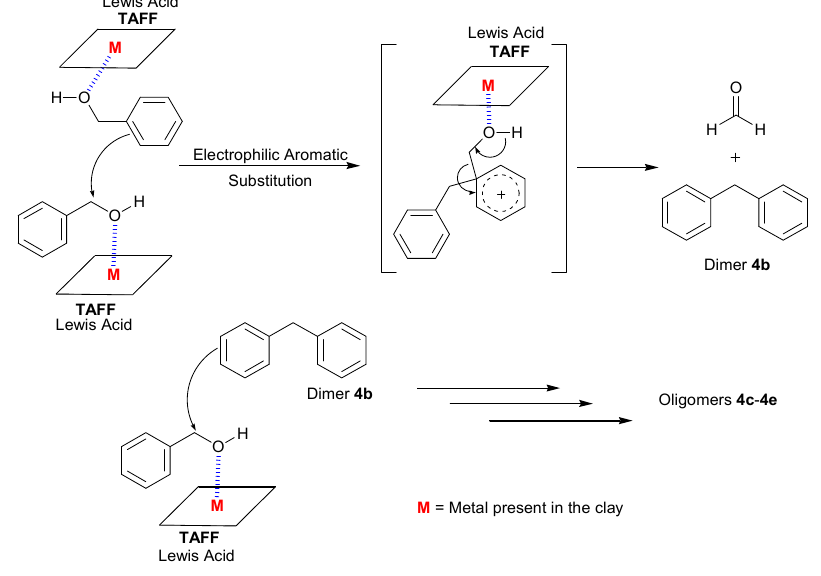
Scheme 1. Proposed reaction mechanism for the oligomerisation